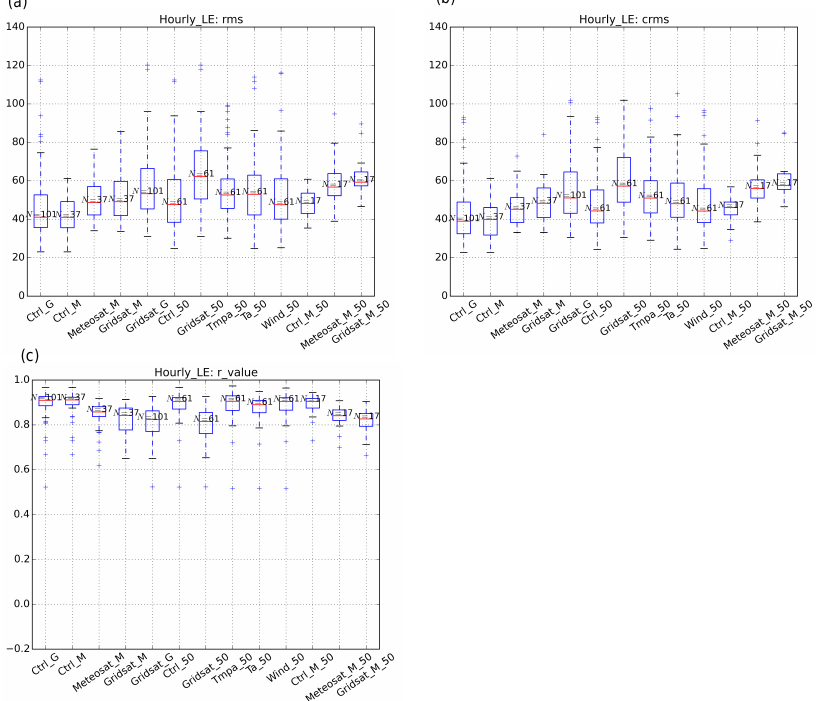
Figure 8. Box plots of (a) RMSD, (b) cRMSD and (c) correlation coefficient for HOLAPS hourly latent heat